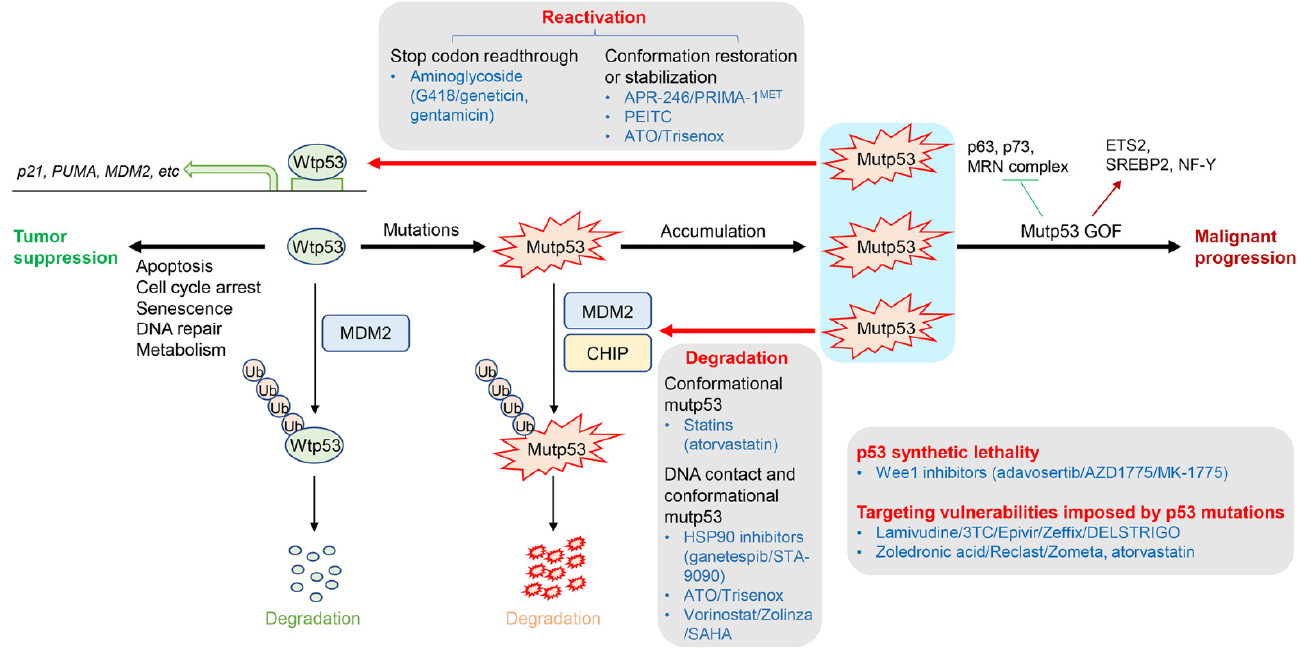
Figure 1. Function of wtp53, mutp53 GOF, and strategies to target p53 mutations.